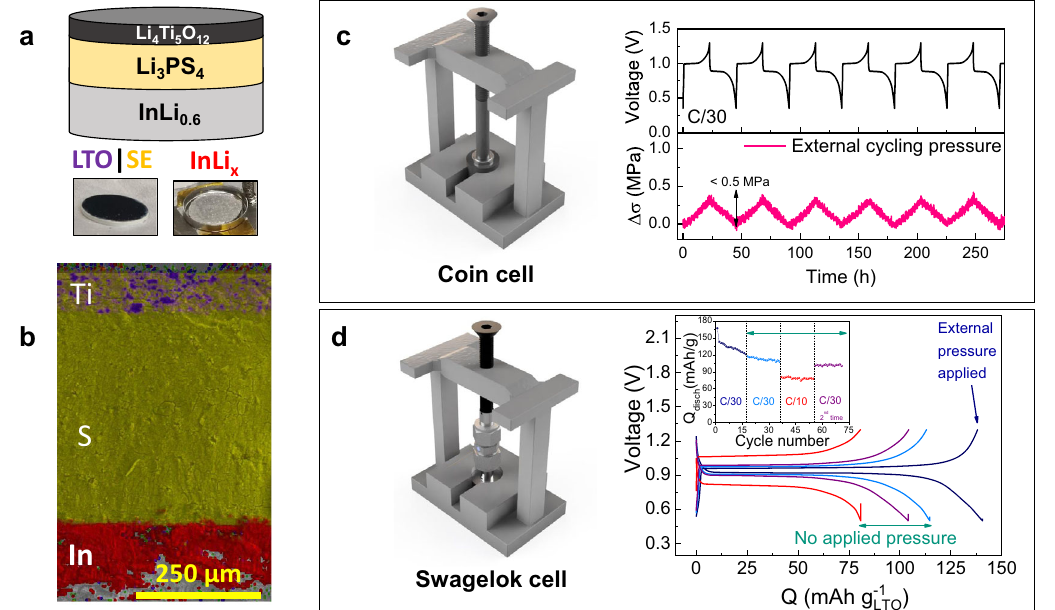
Fig. 3 Fiber-free ASSBs tested in the modi fi ed cell designs. a Scheme of the InLi 0.6 | Li 3 PS 4 | Li 4 Ti 5 O 12 cell and photo of the different battery components. b EDX mapping of the cross-section view of the aforementioned ASSB. The selected elements to track the different battery components are Ti (purple) for the cathode, S (yellow) for the solid electrolyte, and In (red) for the anode. The remaining bright area on the bottom corresponds to metallic Li not alloyed. The measured thickness for each layer is 84.98, 429.0, and 147.0 μ m, respectively. An EDX mapping of the ASSB with the implemented optical fi ber can be seen in Supplementary Fig. 8. c Scheme of the coin cell placed under a frame with an external force sensor. The galvanostatic cycling of the ASSB (top) is presented together with the external cycling pressure evolution, monitored with the external force sensor for the ASSB cycled at C/30 (5.83 mA g − 1 ) and at 25 °C. d Scheme of the Swagelok cell placed under a frame with an external force sensor. Fifth galvanostatic charge/discharge cycle and discharge capacity vs. cycle number (inset) for the ASSB with the following C-rate protocol: the cell was cycled fi rst at C/30 under external pressure applied by the force sensor and then, the Swagelok screws were totally tightened so the ASSB was cycled without additional external pressure at C/30, C/10 (17.5 mA g − 1 ), and C/30 again up to ~70 cycles in total showing good capacity